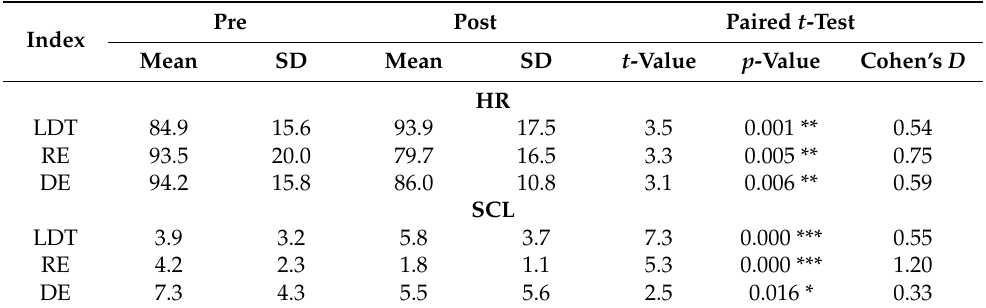
Table 2. The statistical results of physiological indexes (HR and SCL) for pre- and post-test of the LDT, RE, and DE.